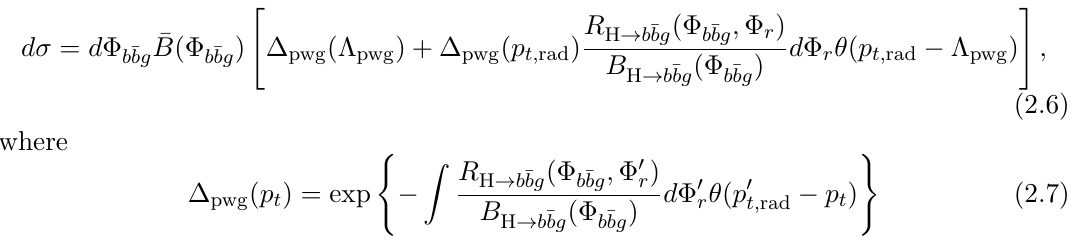
Figure 1 . Numerical check of the NLO accuracy of the Hbbg-MiNLO result. The fact that (cid:14) ( (cid:11) approaches a constant at small (cid:11) (cid:0) MiNLO and (cid:0) NLO agree and that no spurious (cid:11) 3 = 2